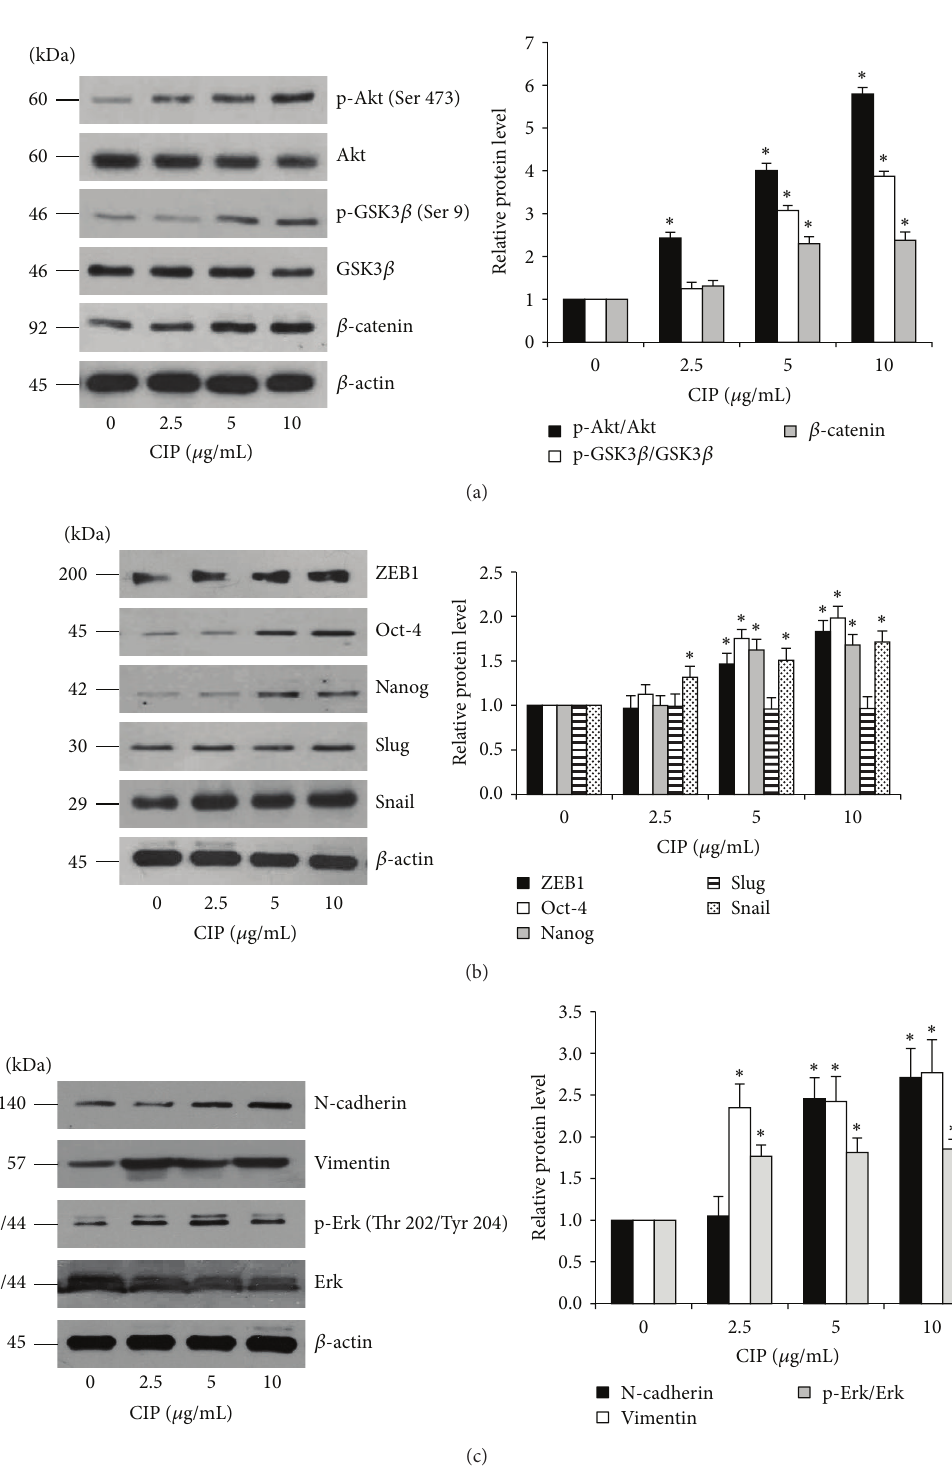
Figure 4: Effects of CIP on Wnt/ 𝛽 -catenin signaling, EMT, and self-renewal transcription factors in DPCs. (a) Cells were treated with CIP (1–10 𝜇 g/mL) for 72 h. After indicated treatment, the levels of Wnt/ 𝛽 -catenin signaling (Akt, p-Akt (Ser 473), GSK3 𝛽 , p-GSK3 𝛽 (Ser 9), and 𝛽 - catenin) were analyzed by western blot analysis. The immunoblot signals were quantified by densitometry and mean data from independent experiments were normalized to the results. (b) EMT and self-renewal transcription factors (ZEB1, Oct-4, Nanog, Slug, and Snail) were determined by western blot analysis. (c) Downstream targets of Snail including N-cadherin, vimentin, total Erk, and p-Erk (Thr 202/Tyr 204) were analyzed by western blot analysis. 𝛽 -actin was used as the loading control. The western blot signals were quantified by densitometry and mean data from independent experiments were normalized to the results. The data represent the means of four independent samples ± SD. ∗ 𝑃 < 0.05 versus untreated